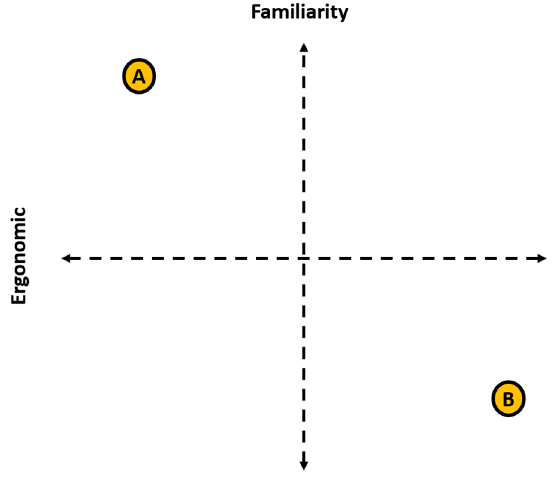
Figure 5. An example of a diagram showing two conflicting demands in a hand-held operational tool.